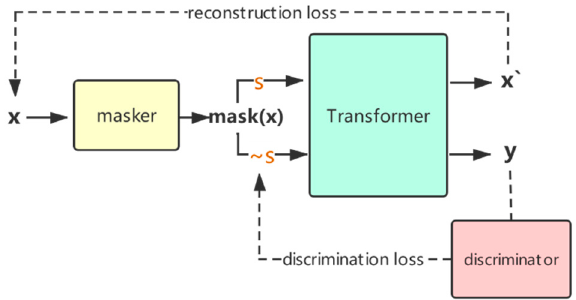
Figure 2. The architecture of the model.